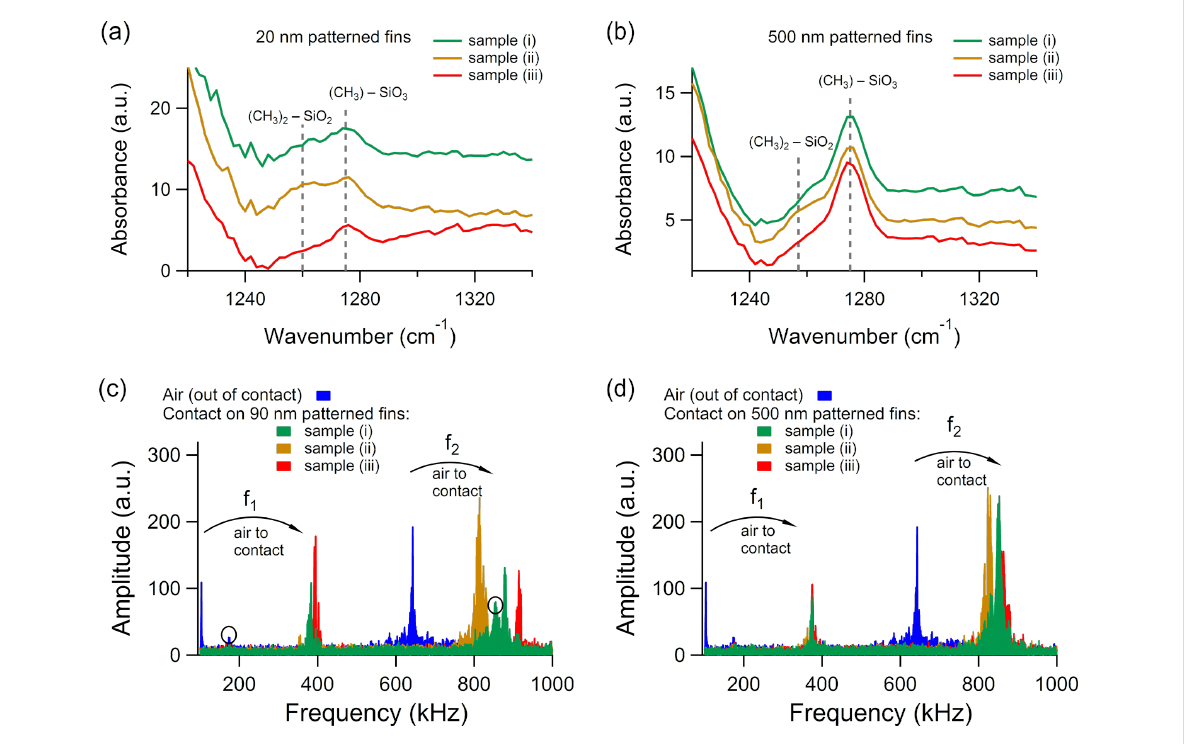
Figure 4: (a) and (b) AFM-IR spectra of the symmetric SiC–H 3 deformation mode from the patterned nanoporous organosilicate fins with widths of 20 nm and 500 nm, respectively. (c) and (d) CR-AFM spectra of the first two eigenmodes from the patterned nanoporous organosilicate fins with widths of 90 nm and 500 nm, respectively. The circled peaks were observed in all the measurements and isolated as spurious resonances. The sam- ple labeling is: (i) after pattern transfer, (ii) after chemical silylation treatment, and (iii) after metallization process